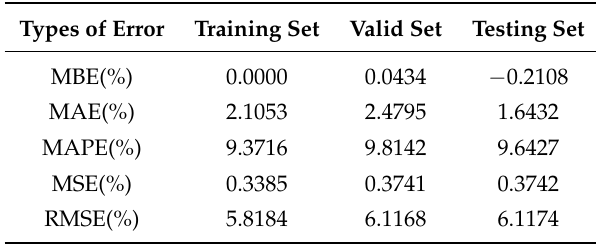
Table 1. Performance of forecasting